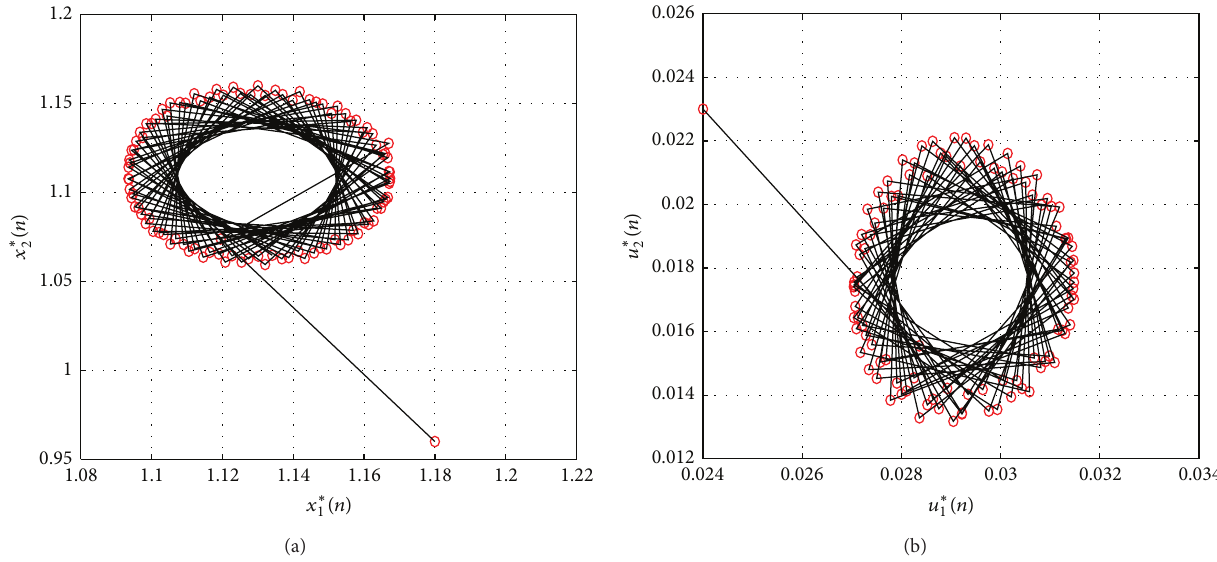
Figure 2: 2-dimensional phase portrait. (a) Phase portrait of 𝑥 ∗ 1 (𝑛) and 𝑥 ∗ 2 (𝑛) with initial values 𝑥 ∗ 1 (0) = 1.18, 𝑥 ∗ 2 (0) = 0.96 for 𝑛 ∈ [0, 100] , respectively. (b) Phase portrait of 𝑢 ∗ 1 (𝑛) and 𝑢 ∗ 2 (𝑛) with initial values 𝑢 ∗ 1 (0) = 0.024, 𝑢 ∗ 2 (0) = 0.023 for 𝑛 ∈ [0,100] ,